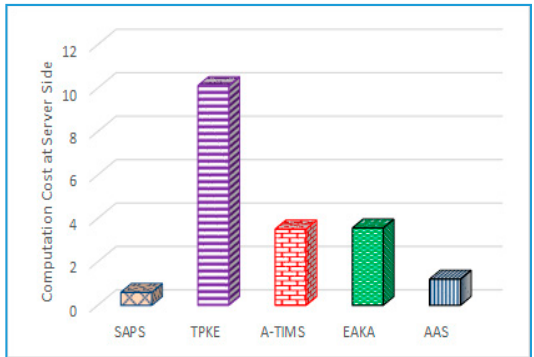
Figure 7. Computation cost at server side.